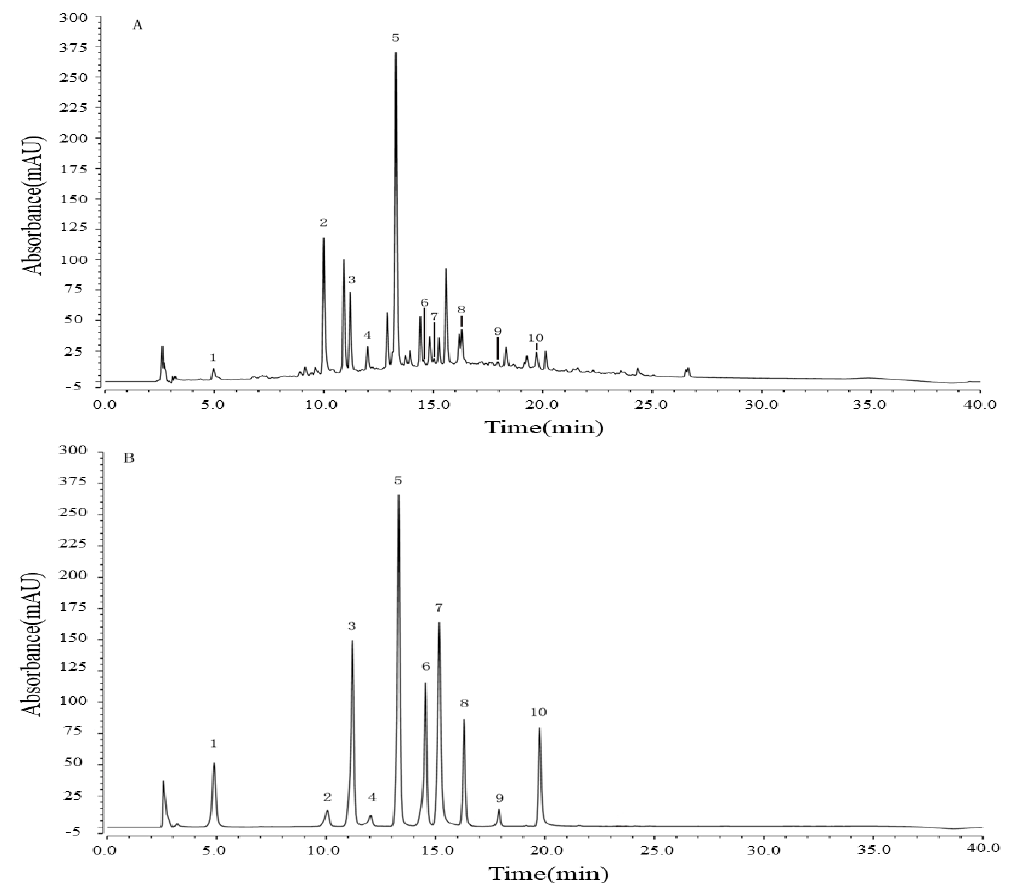
Figure 7. Analysis of the constituents of WST extracts via HPLC assay. ( A ): WST chromatogram; ( B ): standard